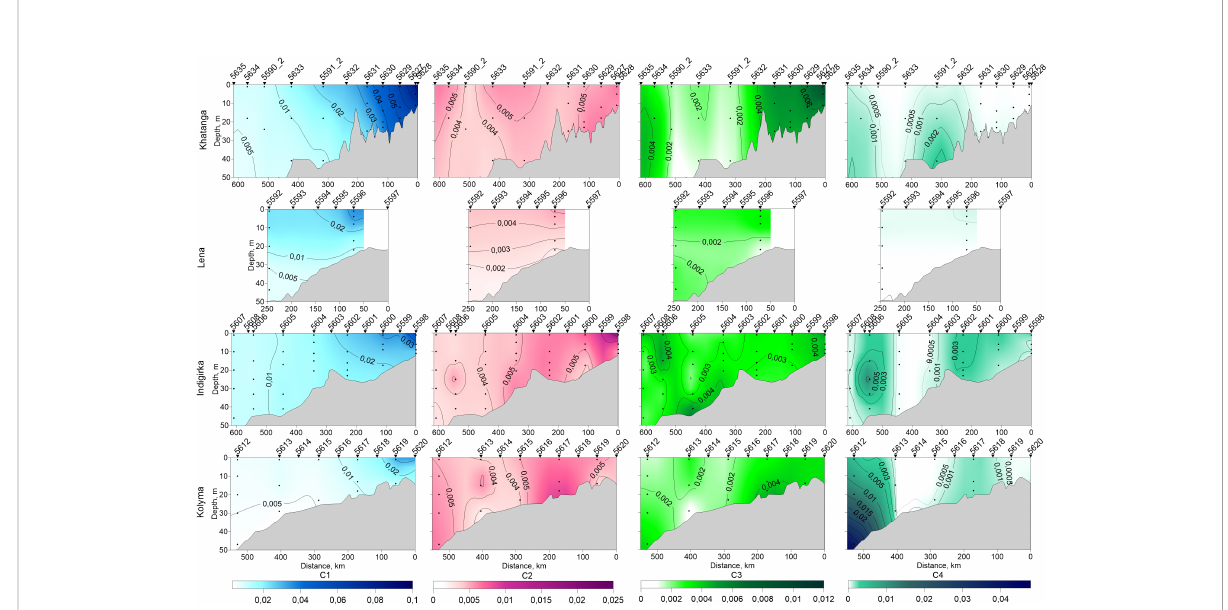
FIGURE 6 Distribution of PARAFAC components C1 – C4 along the Khatanga (17 – 19 September, 2017), Lena (2 – 3 September, 2017), Indigirka (5 – 7 September, 2017) and Kolyma (8 – 9 September, 2017) transects, obtained from the original data points, marked by black